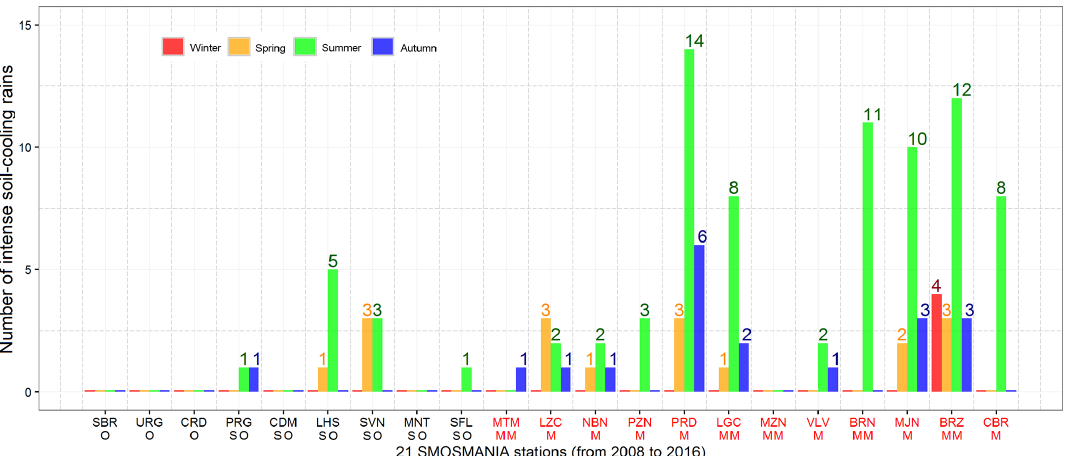
Figure 6. Statistical distribution of the 122 intense soil-cooling rains among stations of the SMOSMANIA network across seasons. Red, orange, green, and blue bars are for winter, spring, summer, and the autumn, respectively. Symbols “O”, “SO”, “M”, and “MM” indicate oceanic, semi-oceanic, Mediterranean, and Mediterranean–mountain climates, respectively. Stations are listed from (left) west to (right) east.